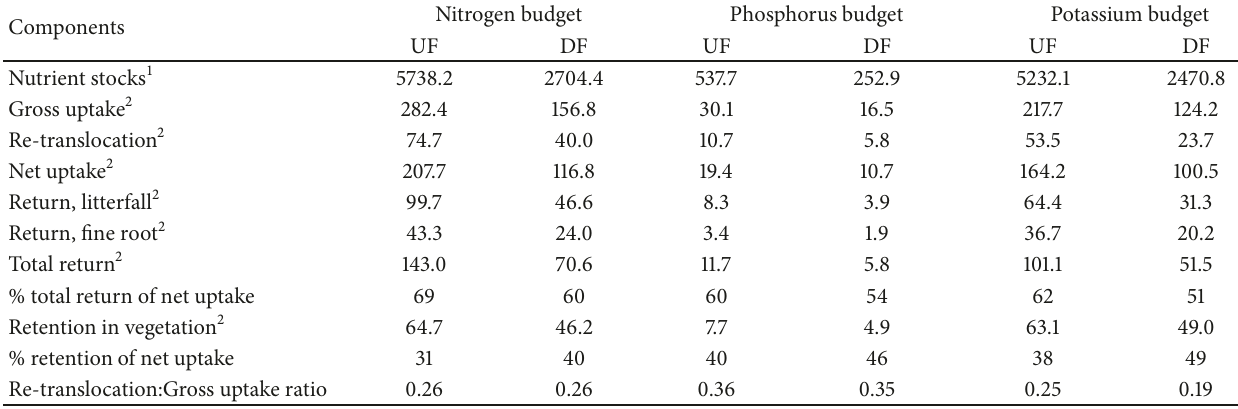
Table 13: Nitrogen, phosphorus, and potassium budget for vegetation in undisturbed forest stand (UF) and disturbed forest stand (DF) of moist tropical forest in Sunsari district, eastern